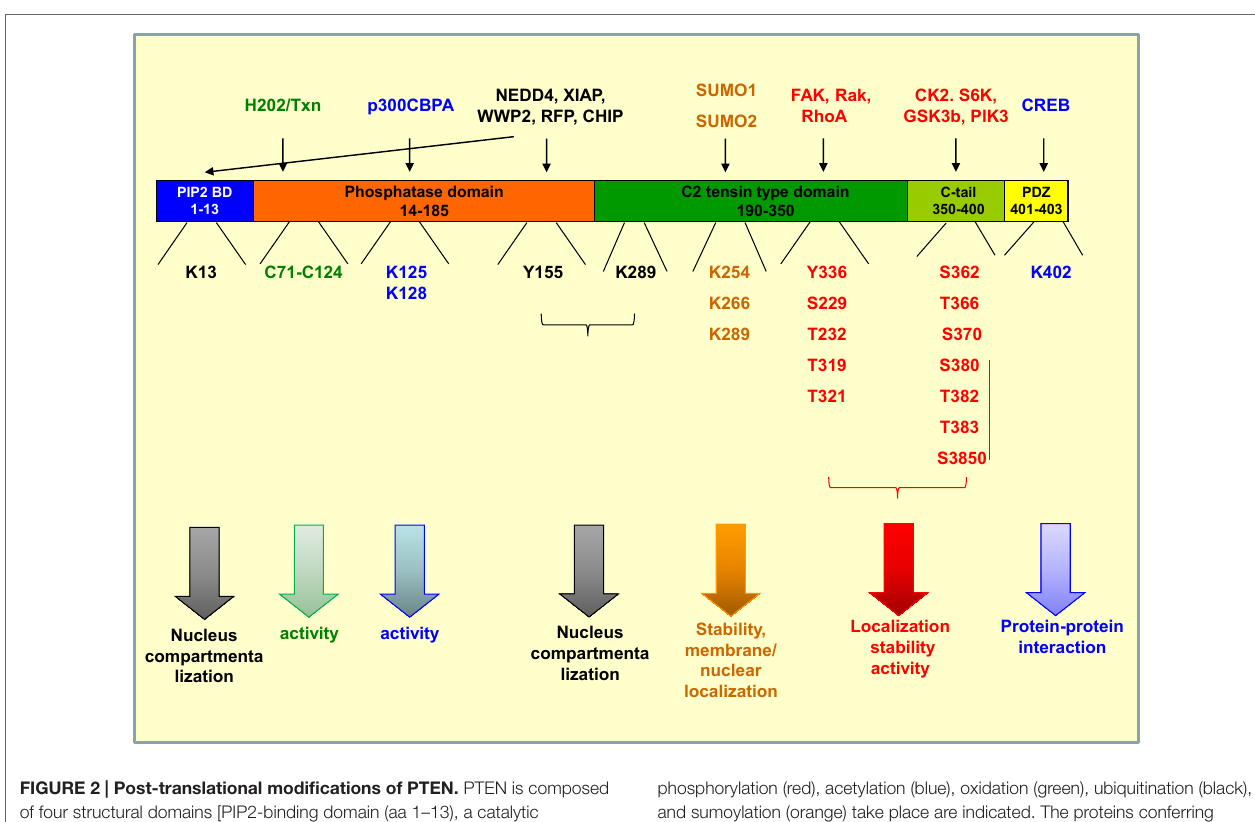
FiGURe 2 | Post-translational modifications of PTeN. PTEN is composed of four structural domains [PIP2-binding domain (aa 1–13), a catalytic tensin-type phosphatase domain (aa 14–185), a C2 tensin-type domain, which binds phospholipids (aa 190–350), the carboxy-terminal tail of the protein (aa 350–400), and a PDZ-binding domain (aa 401–403). The residues where